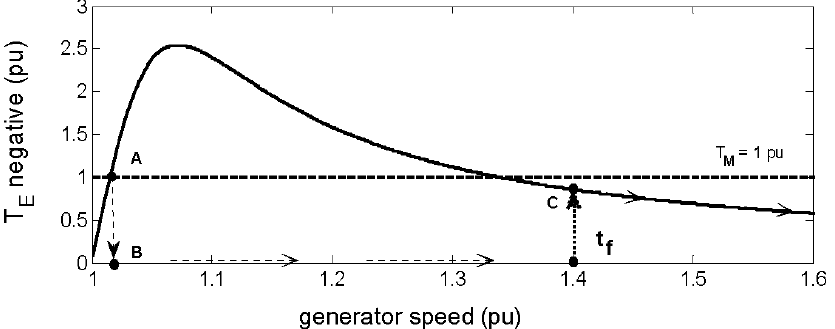
Figure 6. Unstable operation of squirrel-cage induction